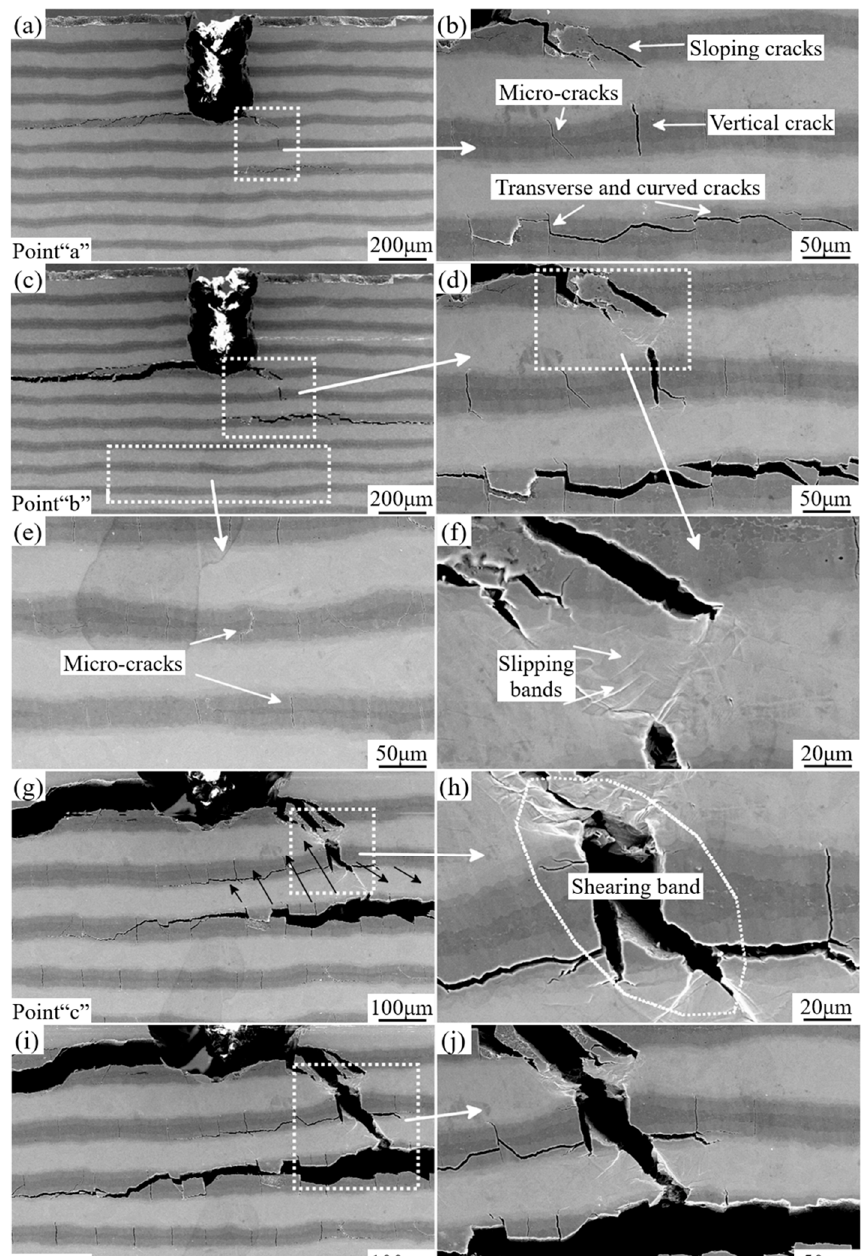
Figure 7. Scanning Electron Microscopy (SEM) micrographs of the in-situ three-point bending test corresponding to the first part of the Load-displacement curve representing the cracks nucleation and propagation process: ( a ) and ( b ) represent the detailed deformation morphologies of the specimen corresponding to the ”Point a” in Figure 6, showing several cracks initiated and propagated within the brittle intermetallic layers; ( c ), ( d ), ( e ), and ( f ) correspond to “Point b” in Figure 6, showing the crack bridging, slipping bands of Ti layers and more micro-cracks in intermetallic layers; ( g ) and ( h ) correspond to “Point c” in Figure 6, showing the shearing band in Ti layers and thorough fracture of the intermetallic layers; ( i ) and ( j ) correspond to “Point d” in Figure 6, showing the thorough fracture of the local Ti layers and Intermetallic layers.